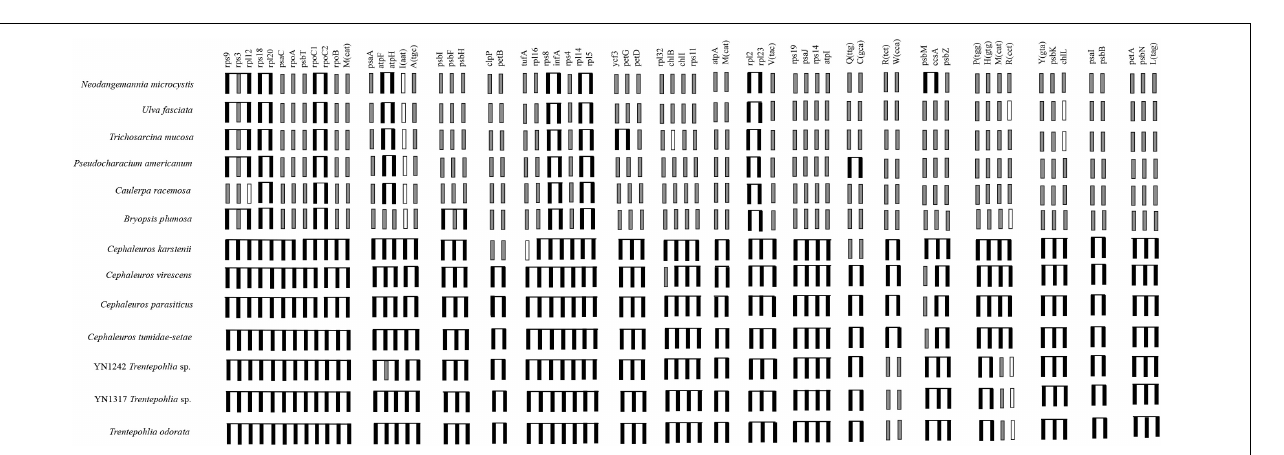
FIGURE 6 | Comparison of gene clusters conserved in Trentepohliales with gene order found in six Ulvophycean lineages. Black connected boxes indicate gene clusters that made up of contiguous genes. Black boxes that are contiguous but are unlinked indicate that the corresponding genes are not adjacent on the genome. Gray boxes indicate genes that are located elsewhere on genome. White boxes indicate genes that are missing from the chloroplast